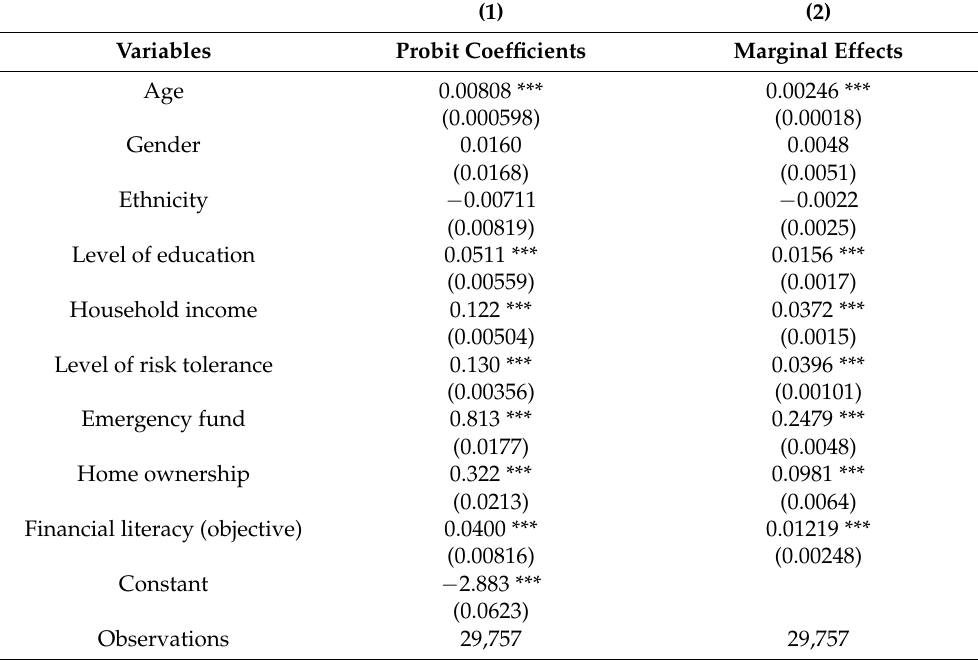
Table 6. Probit model with original data (objective financial knowledge variable